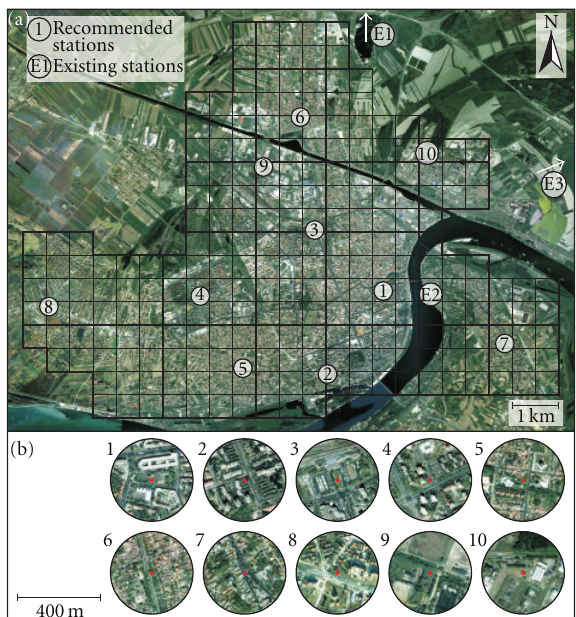
Figure 7: Satellite image of the study area in Novi Sad [45] with the existing stations and the recommended sites of a 10-station urban climate network (a) and the immediate surroundings (diameter— 400 m) of these sites (b) (E1—Rimski ˇSanˇcevi, E2—Petrovaradin,